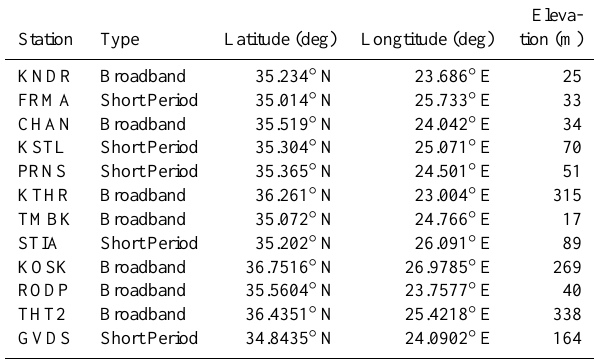
Table 1. List of seismic station of the HSNC along with their coor- dinates, codes and sensor